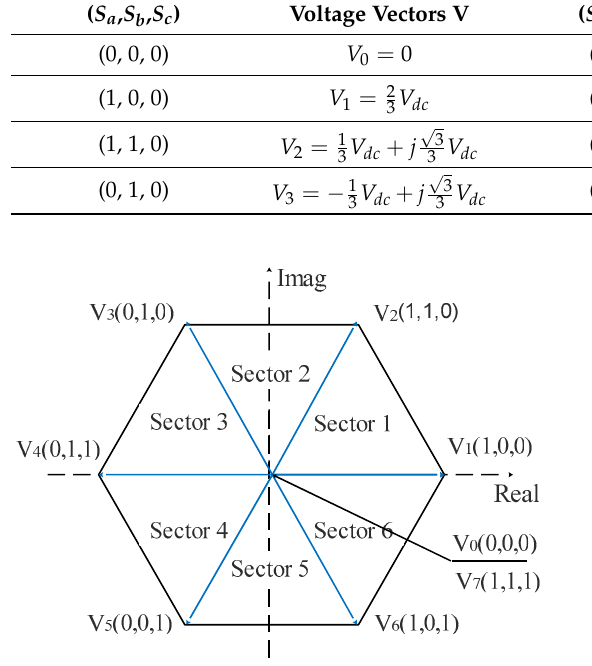
Figure 3. Voltage vectors of the two-level VSI.